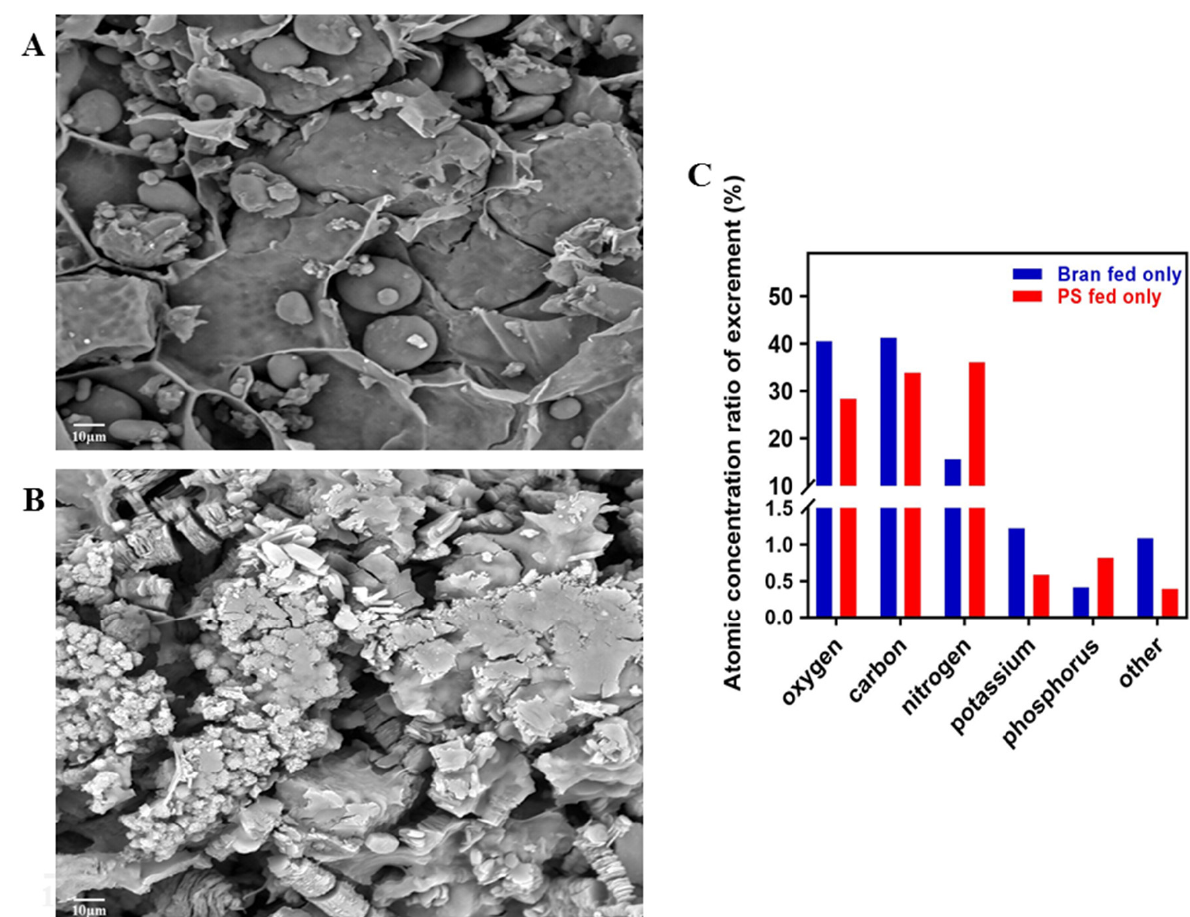
Figure 2. Physical and chemical representation of excrement. ( A ). The excrement of bran-fed larvae. ( B ). The excrement of PS-fed larvae. ( C ). The ratio of atomic concentrations of major elements in excrement in the bran and PS groups.